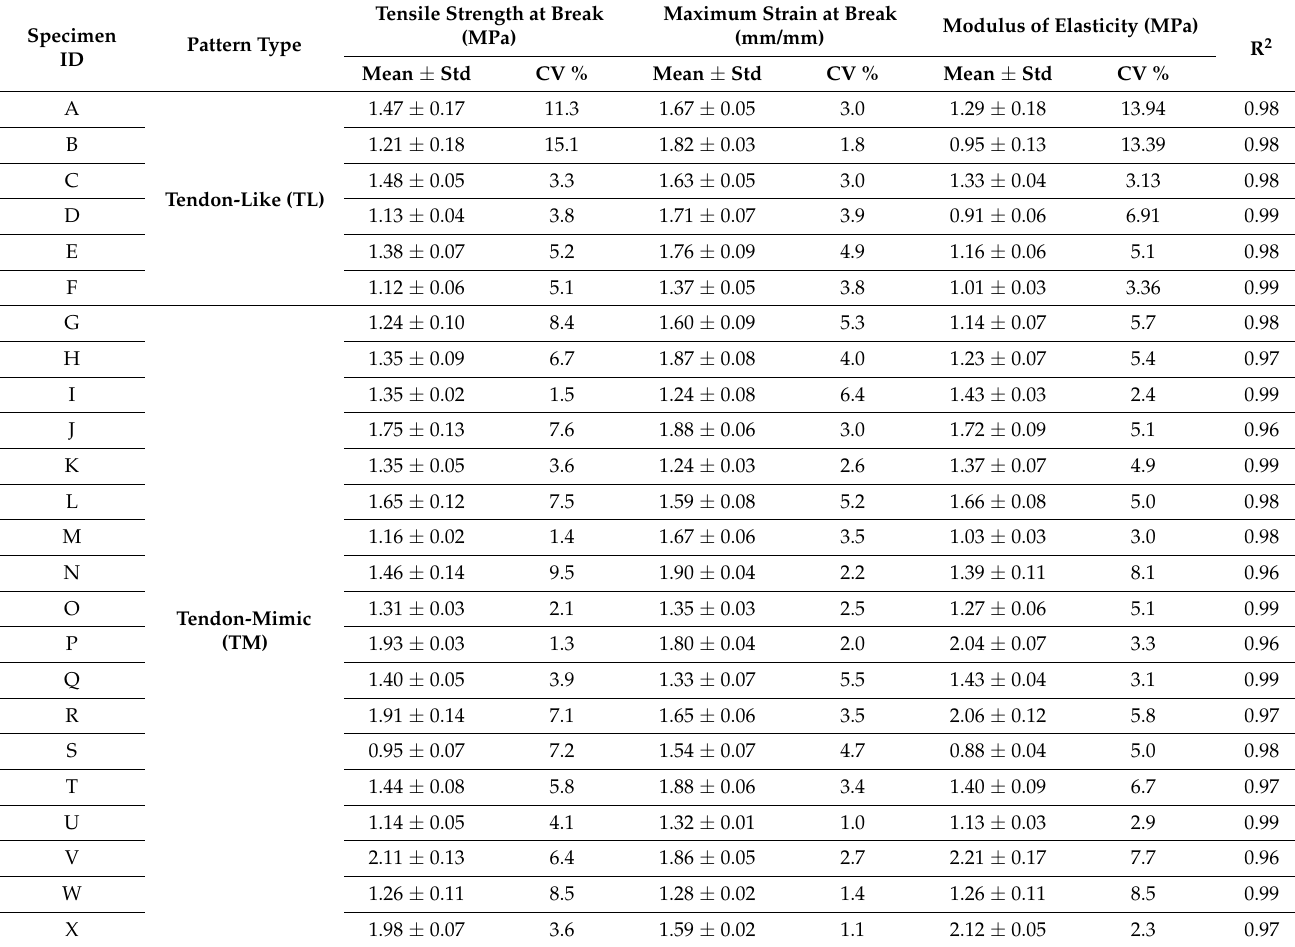
Table A2. The soft tissue-mimicking polymers’ mechanical properties. Mean ± standard deviation (std) values, coefficient of variation (CV%), and Pearson’s coefficient (R 2 ) are